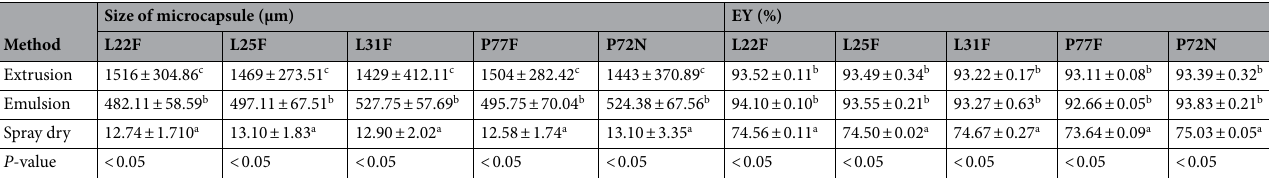
Table 1. Size and EY of the microcapsules. The different lowercase letters within each column indicate significant differences between methods ( P < 0.05).